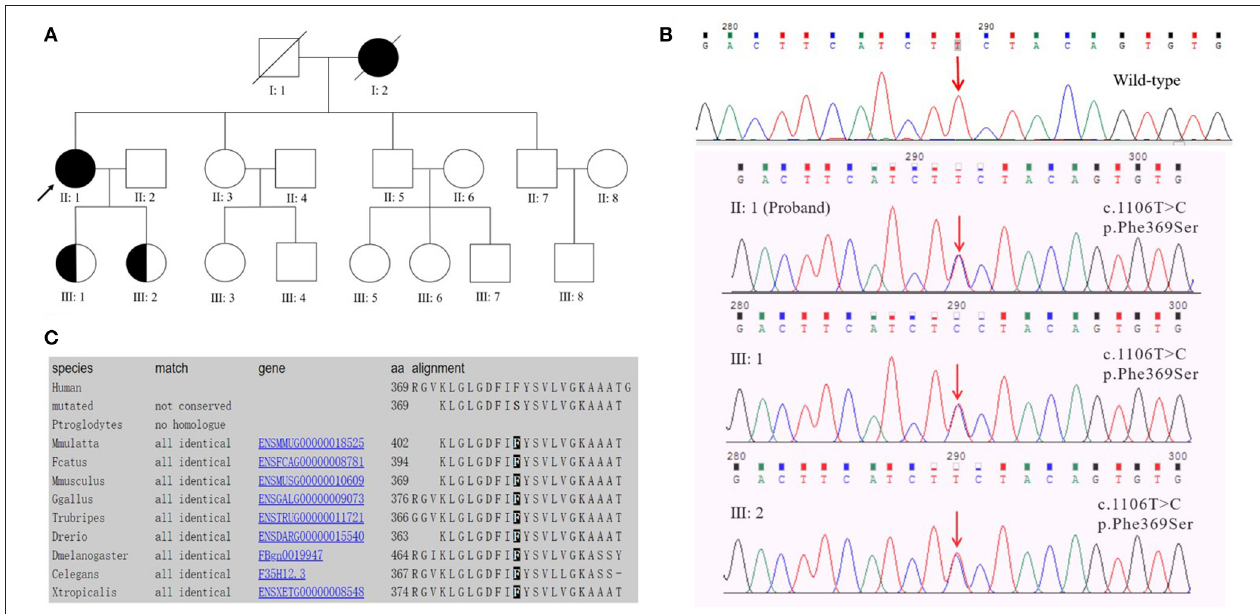
FIGURE 1 | (A) Pedigree of early-onset Alzheimer’s disease with the PSEN2 Phe369Ser mutation. The proband is marked with an arrow; circles and squares represent females and males, respectively; filled symbols, affected family members; half-filled symbols, mutation carriers (currently with no clinical symptoms of EOAD). Blood samples were available from the proband (II: 1), her sister (II: 3), brothers (II: 5, II: 7), and her daughters (III: 1, III: 2). (B) DNA sequencing chromatography indicated a heterozygous PSEN2c.1106T > C mutation (nomenclature according to NCBI. Reference Sequence: NM_000447.2) in the proband and her two daughters. (C) Evolutionary conservation analysis of phenylalanine (Phe or F) at position 369 among different